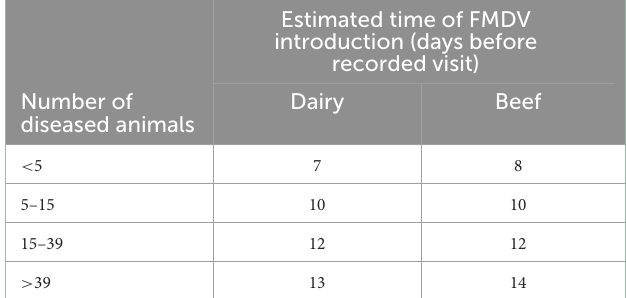
TABLE 2 General rules created by using the results of the FMDV introduction model, which were used to estimate approximate each farm’s infection dates. A simple stochastic susceptible-exposed-infectious- removed (SEIR) model considering only the cattle population was used to describe the transmission of FMD virus within herds.